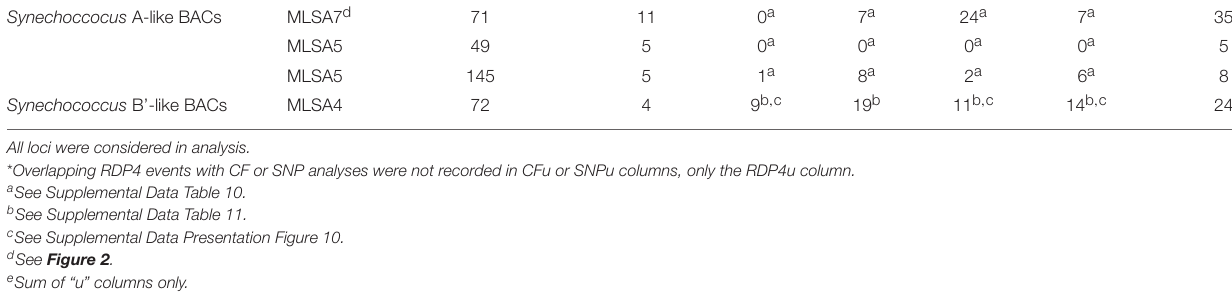
Supplemental Data Presentation Figure 14. Ecotype